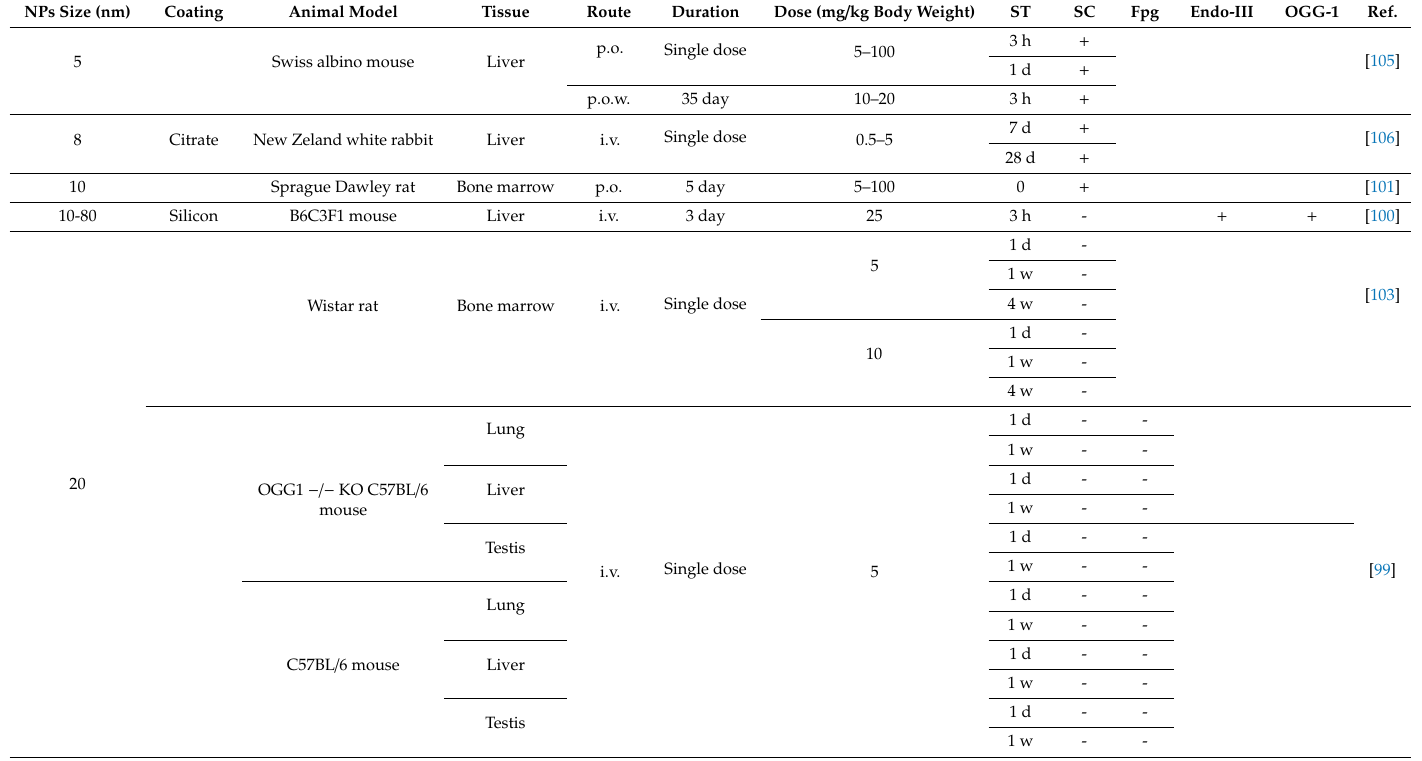
Table 6. In vivo comet assay